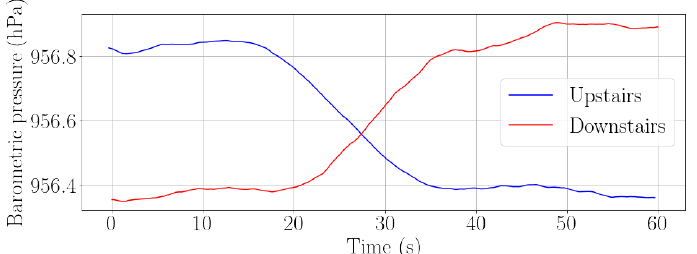
Figure 13. Barometric pressure when a passenger is going upstairs (blue) and downstairs